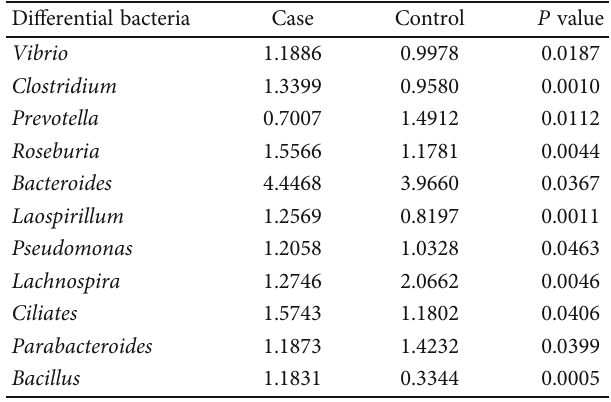
Table 3: A comparison of the di ff erential bacterial genera between the 2